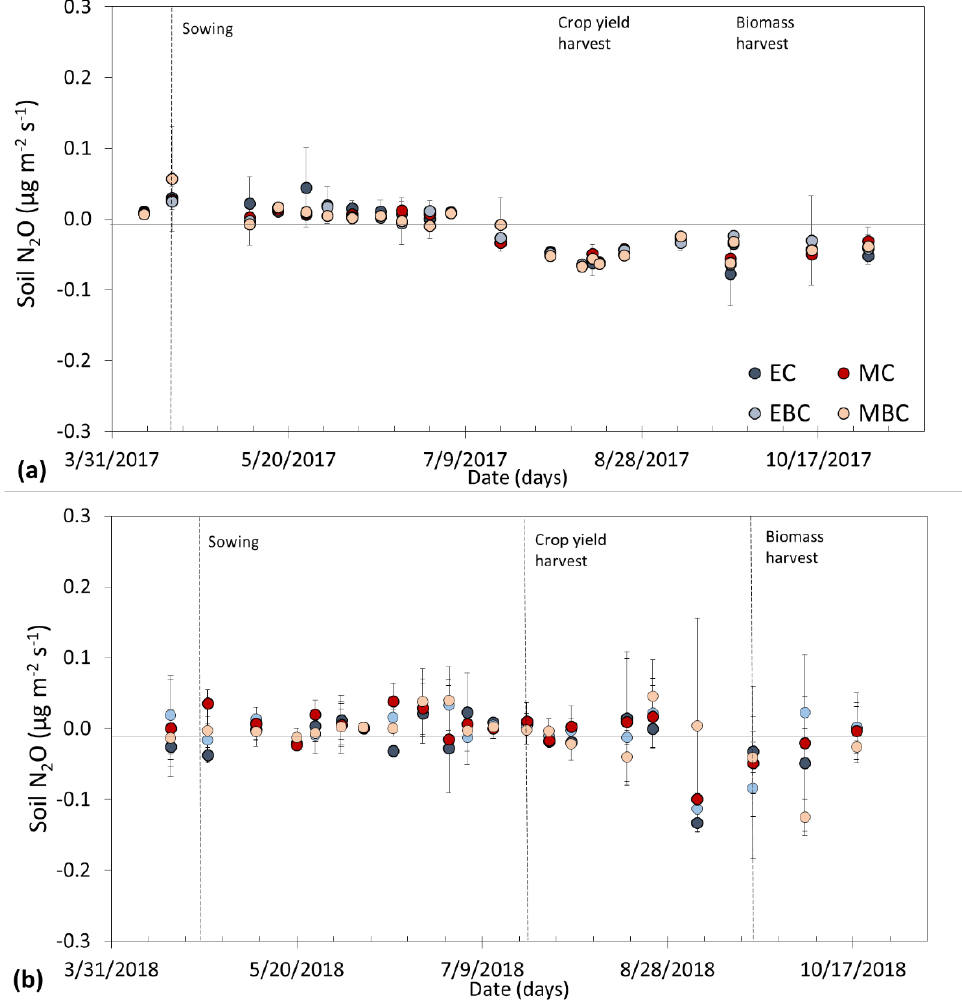
Figure 6. Soil N 2 O emission for the different treatments measured in ( a ) 2017 and in ( b ) 2018. n = 4; ± SD. EC represents empty control plots, MC represents the control plots with maize, EBC represents the empty plots with biochar, and MBC represents the plots with maize and biochar amendment.